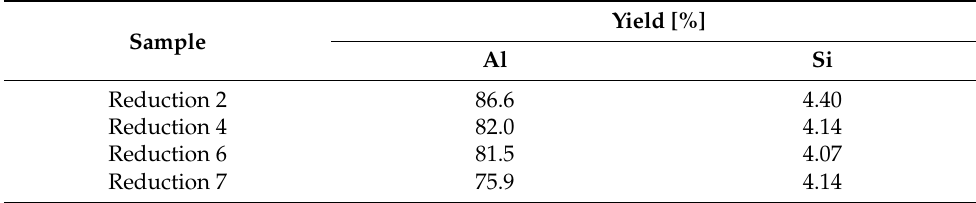
Table 7. Aluminum and silicon yield into the leaching